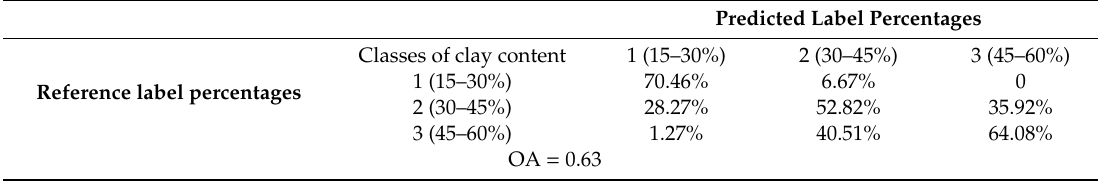
Table 6. Confusion matrix for the SVM classification, using soil moisture products for clay content mapping.